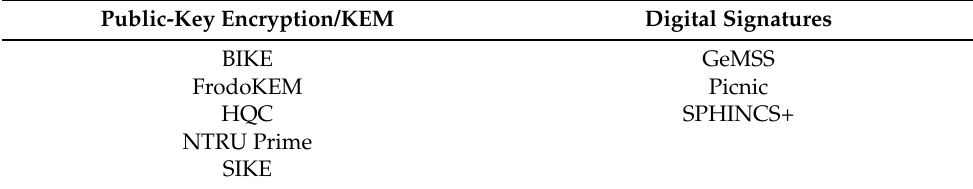
Table 2. The currently alternate candidates of the NIST standardization